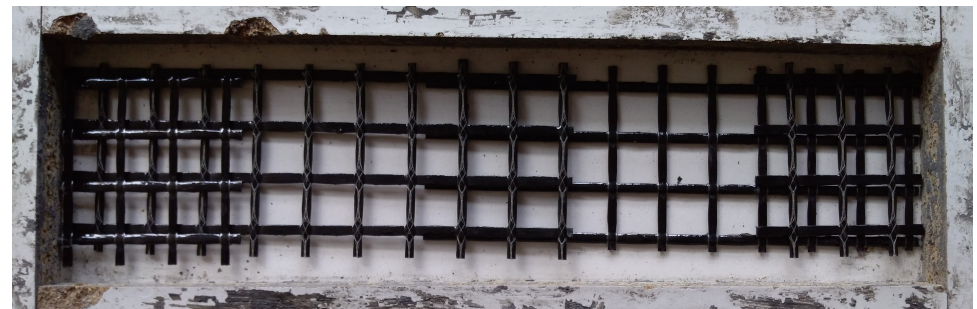
Figure 1. View in the wooden mold just before casting process on the used flat carbon concrete reinforcement with overlapping in the middle part.